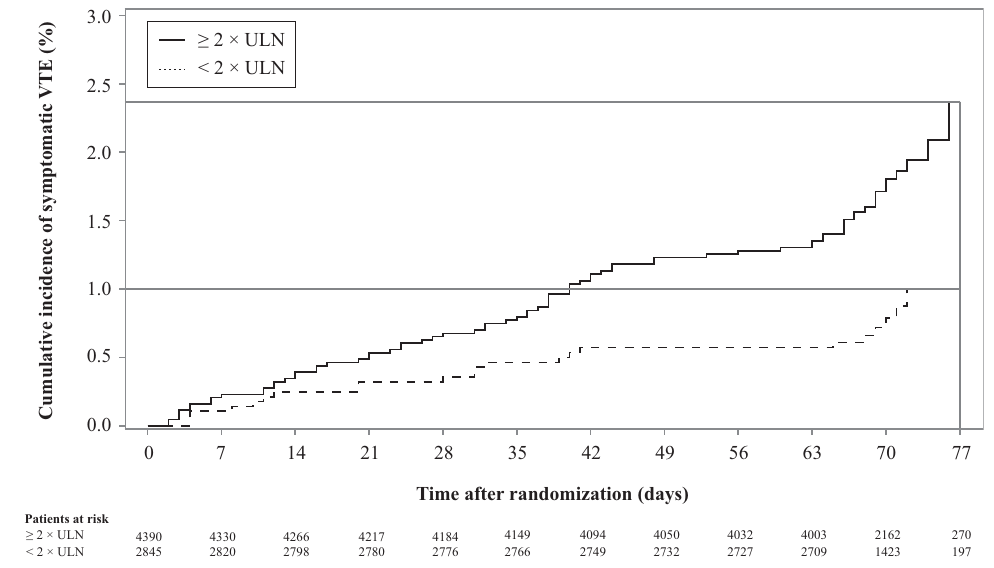
Fig. 1 Kaplan – Meier curves for symptomatic VTE strati fi ed by D-dimer concentration.